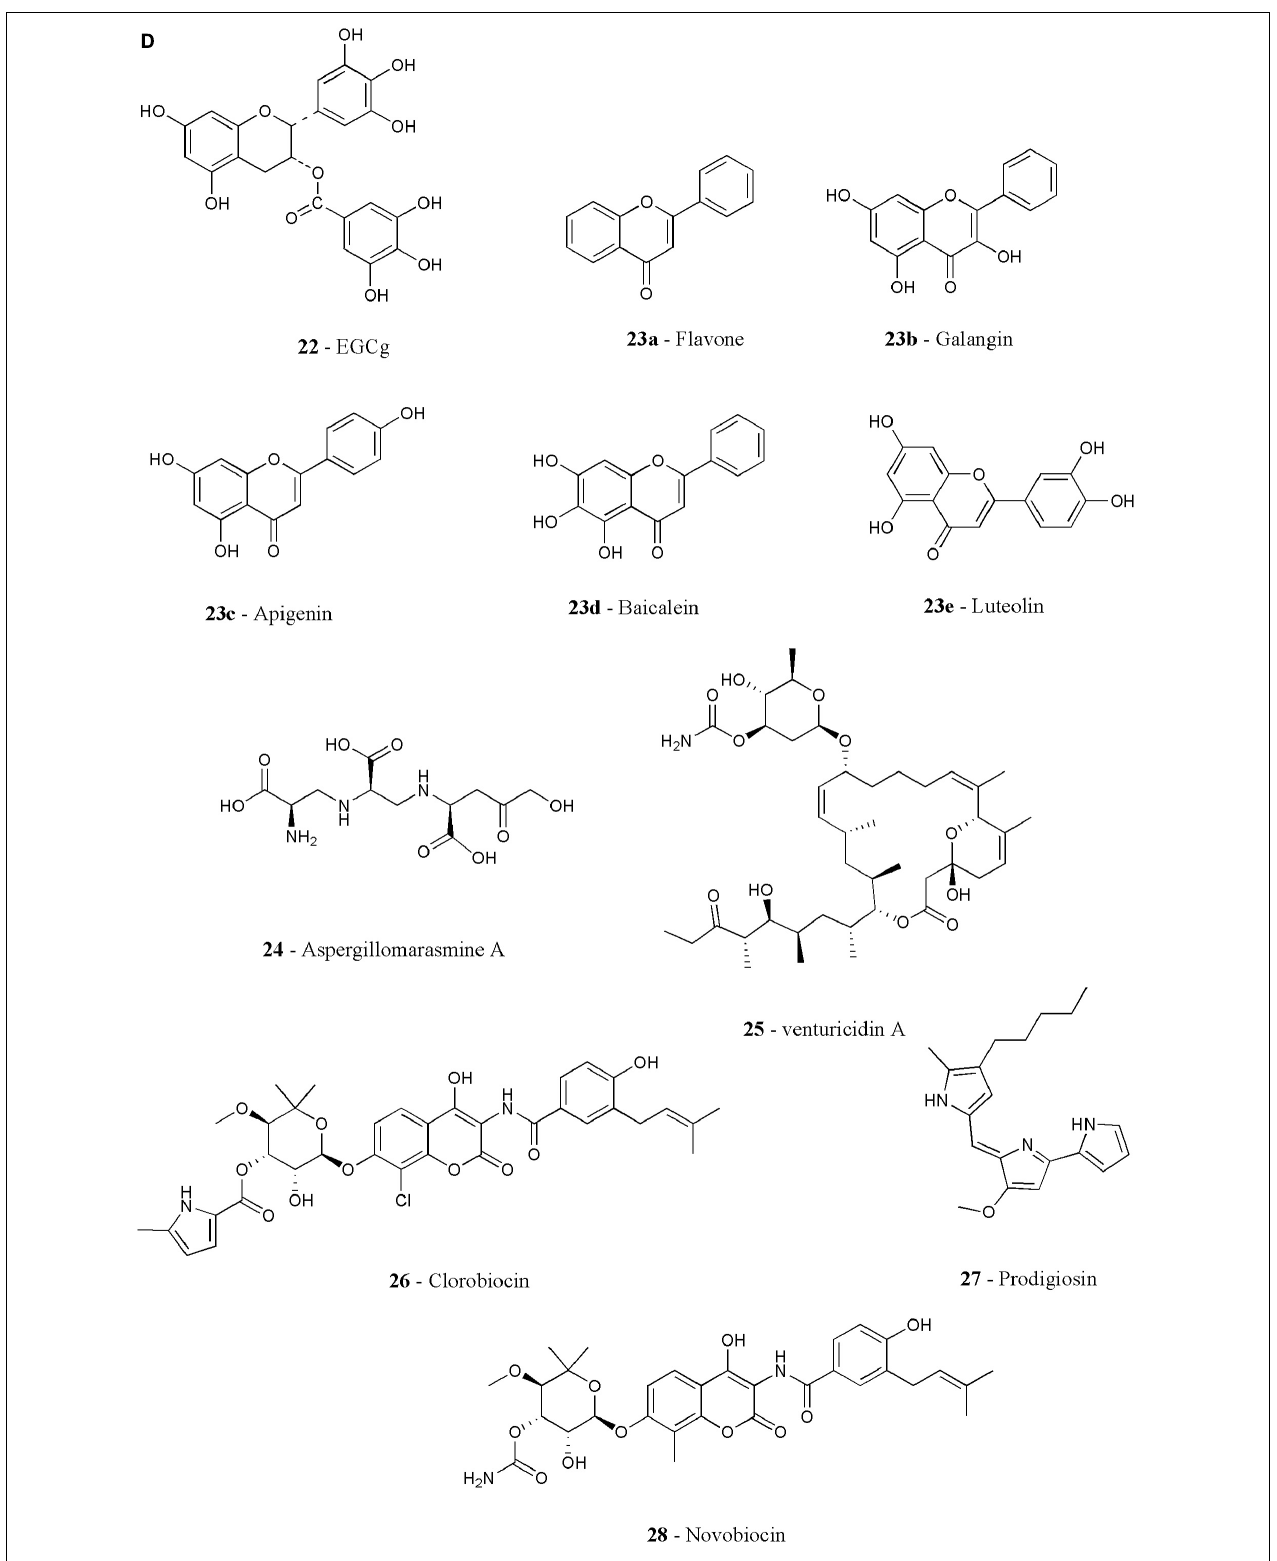
FIGURE 2 | (A) Chemical structure of plasmid curing inhibitors (1-8e). (B) Chemical structure of efflux pump inhibitors (9-16a). (C) Chemical structure of efflux pump inhibitors (17a-21). (D) Chemical structure of resistance enzymes inhibitors (22-28).